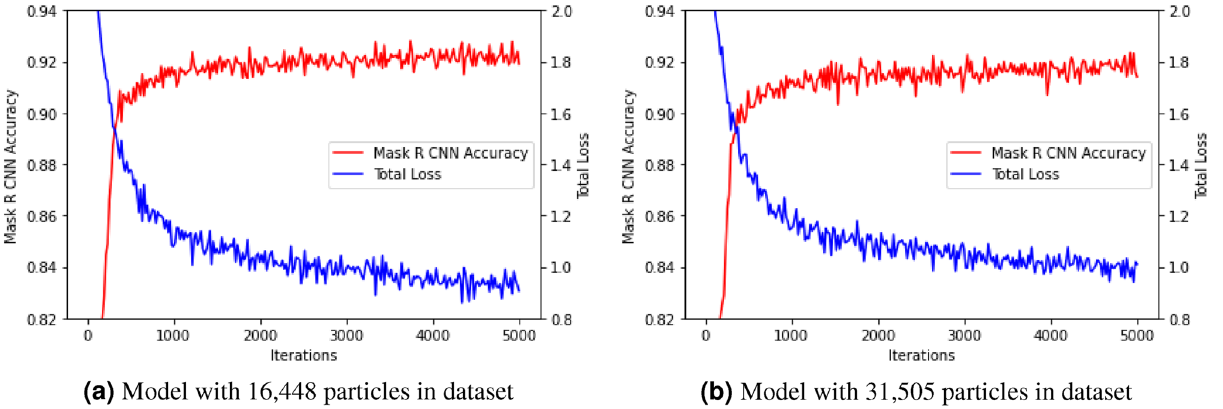
Figure 4. Plot of Mask R CNN training accuracy and Total Loss during training with steps of iterations for the model with ResNet50 plus FPN as backbone